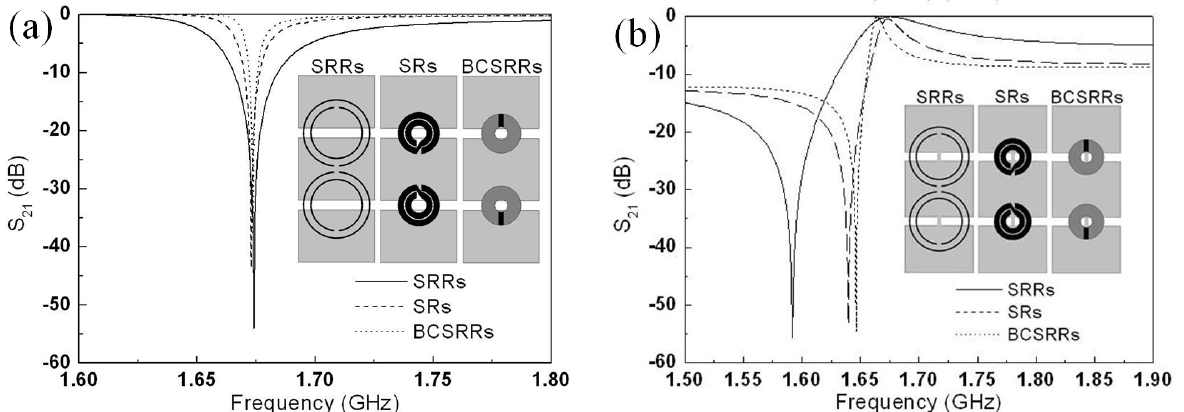
Figure 10. Layouts and transmission coefficients of several CPWs loaded with pairs of SRRs, BC-SRRs and 2-SRs ( a ) and with shunt strips ( b ). Relevant dimensions are: Ring width c = 0.2 mm, distance between the rings d = 1 mm, external radius r = 5.4mm for ext the SRRs; c = 0.961 mm, d = 0.19 mm, r = 3.36 mm for the SRs; and c = 2.12 mm, ext d = 0.2 mm, r = 3.17 mm for the BCSRRs. For the CPW the central strip width is ext W = 10 mm, the width of the slots is G = 1.59 mm and the length D = 12.2 mm. Shunt C strip width w = 0.2 mm. The considered substrate characteristics are: dielectric constant S  = 10.2 and thickness h = 2.54 mm. From [38]; copyright  2010, John Wiley & Sons ; r reprinted with